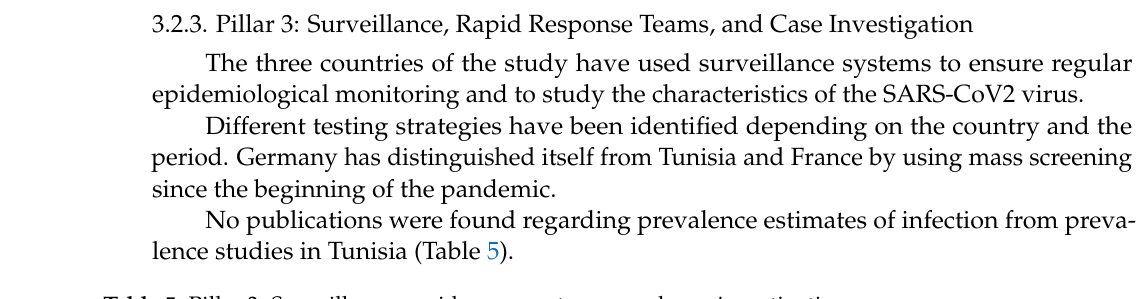
Table 5. Pillar 3: Surveillance, rapid response teams, and case